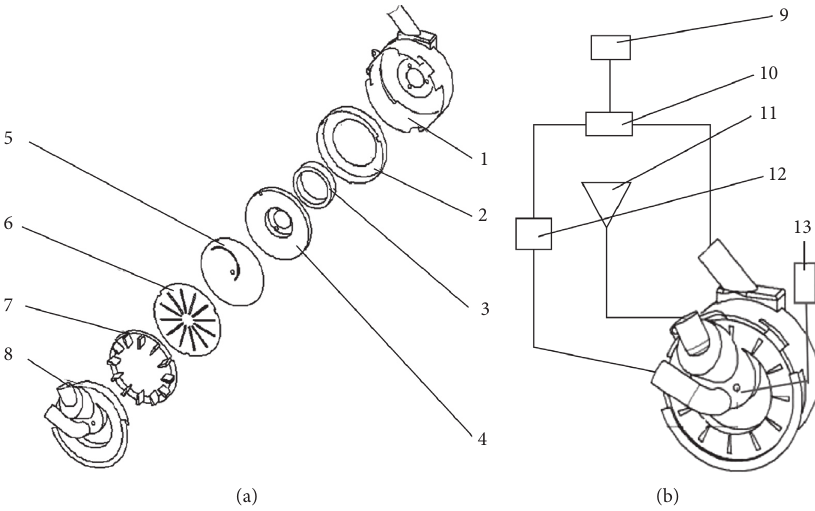
Figure 3: Structure of air suction seed metering device. (a) Seed meter exploded view. (b) Seed meter combination view. (1) Shell of seed meter. (2) Disk drive. (3) Bearing. (4) Guide groove plate fixing device. (5) Guide groove plate. (6) Air suction plate. (7) Forced seeding plate. (8) Storage seed